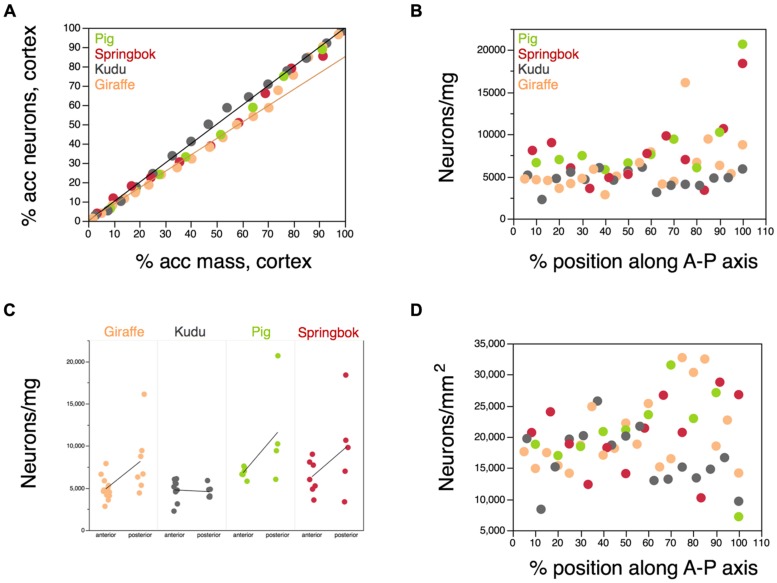
Distribution of neurons along the anteroposterior axis of the cerebral cortex. Each artiodactyl species is represented in a different color. (A) Cumulative percentage of neurons along the anteroposterior axis of the cerebral cortex plotted as a function of the cumulative mass of the gray matter of the cerebral cortex along the same axis. Anterior is to the left. Each point represents the values for one 6 mm block of cortex along the axis. The plotted line indicates the linear relationship expected for a uniform distribution of neurons in the cortical mass along the anteroposterior axis. While the kudu fits the uniform distribution, the springbok, pig, and giraffe deviate in such a manner that the cumulative distribution of neurons along the cortical mass is better described by a different function (plotted) in the anterior 2/3 of the cortical mass. (B) Variation in neuronal density in each 6 mm block of cerebral cortex along the anteroposterior (A-P) axis. Anterior is to the left. While there is little variation in neuronal density along the cortex of the kudu, densities vary by 4–5× among cortical blocks in the pig, springbok and giraffe. (C) Difference in neuronal densities found in the anterior 2/3 and in the posterior 1/3 of the cerebral cortex in each species. Averages in each group are shown for each species. The largest neuronal densities are found in the posterior 1/3 of the cortex in the giraffe, pig, and springbok. (D) Variation in the surface density of neurons in the cortex (that is, neurons/mm2) in each 6 mm block of cerebral cortex along the anteroposterior axis. Despite the large variation along the cortex of each species, there is no systematic difference in surface density of neurons along the A-P axis.